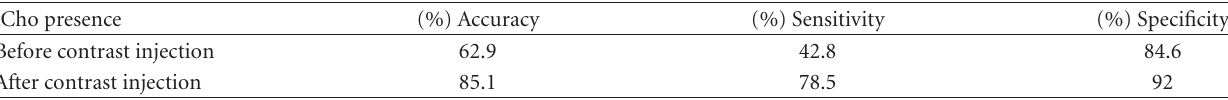
Table 2: Measures of overall accuracy, sensitivity, and specificity using tCho presence in discrimination of benign from malignant breast